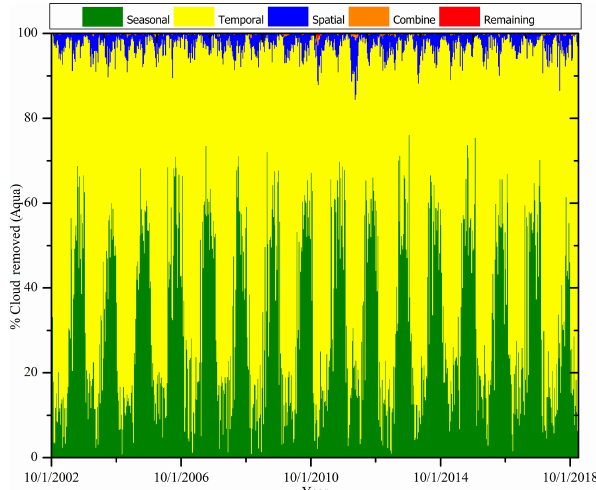
Figure 6. Cloud cover removed from the Aqua product by seasonal filter, temporal filter, spatial filter, combining improved MOD10A2 and MYD10A2, and remaining cloud cover. The seasonal, tempo- ral, and spatial labels in the legend indicate the respective filters.